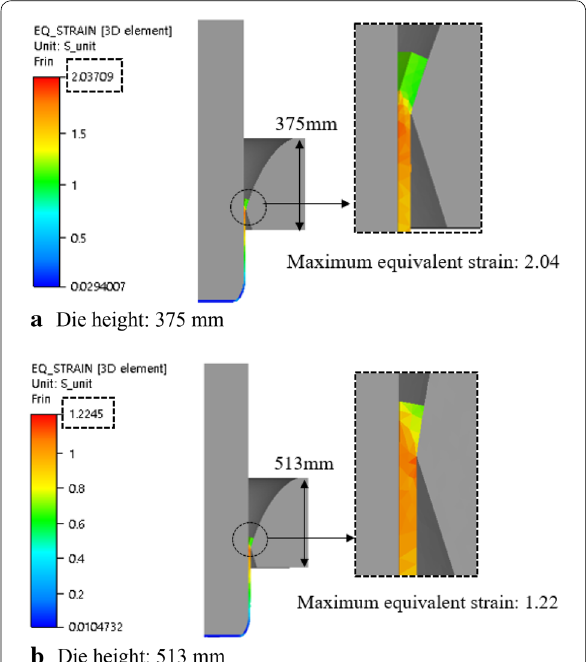
Figure 14 Equivalent strain distributions when the die heights are 375 mm and 513 mm